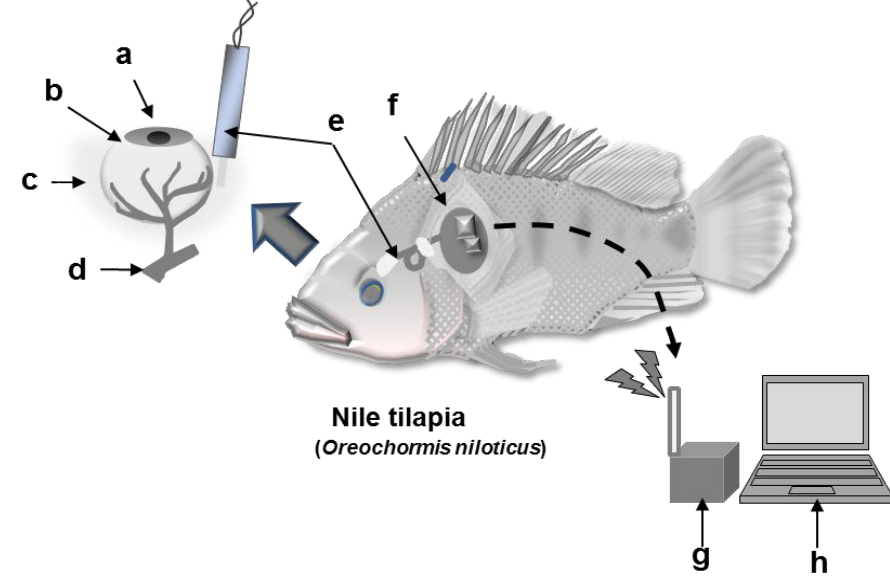
Figure 2. Schematic diagram of the wireless monitoring system for fish. ( a ) Eyeball, ( b ) Sclera, ( c ) EISF, ( d ) Blood vessel, ( e ) Needle-type L -lactic acid sensor, ( f ) Wireless potentiostat, ( g ) Receiver, ( h ) Personal